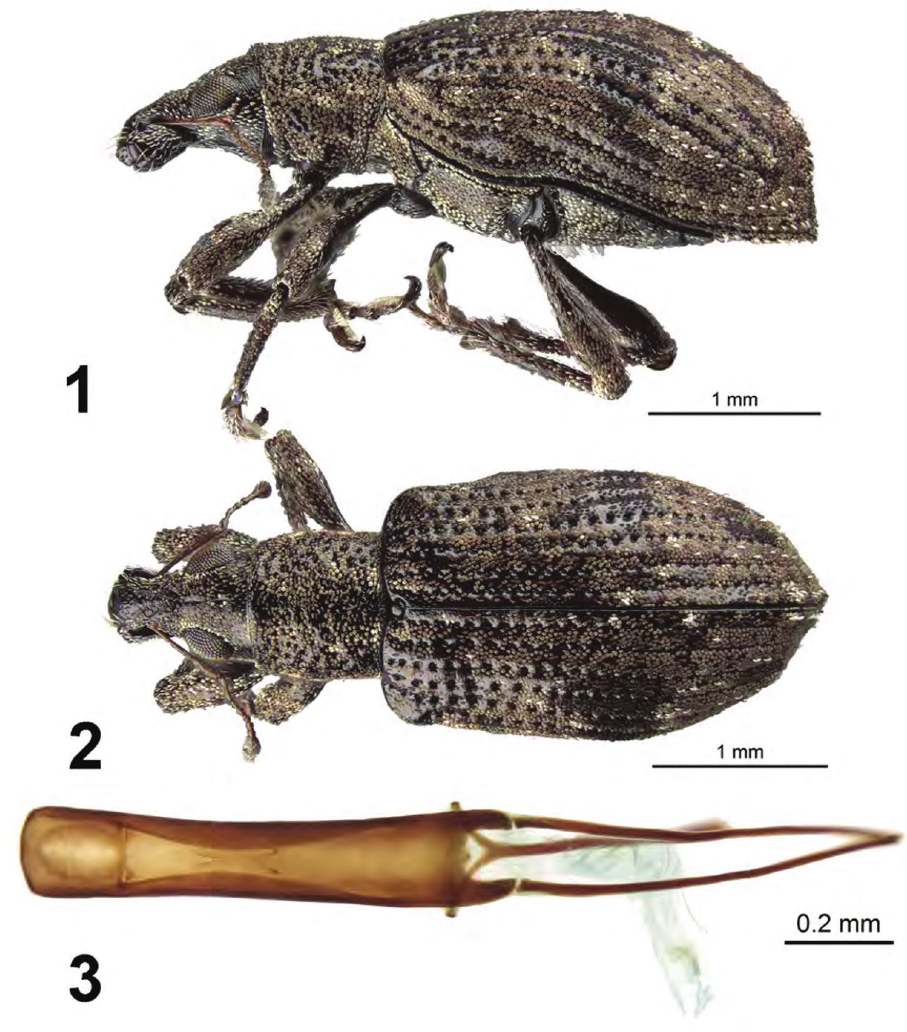
Figures 1–3. Apodrosus alberti. 1 Lateral habitus, female 2 Dorsal habitus, female 3 Male aedeagus,